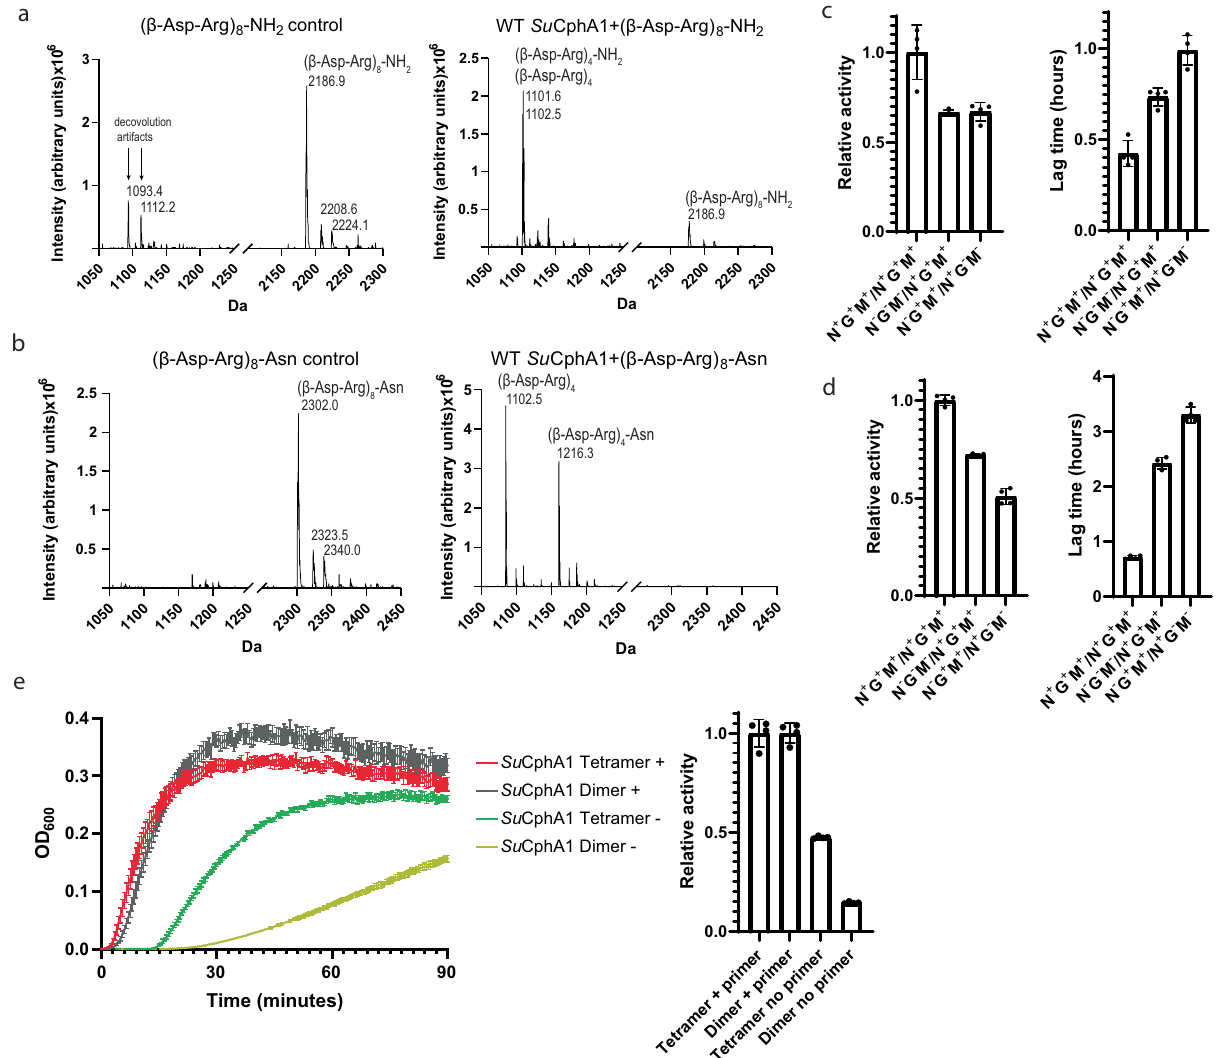
Fig. 4 Catalytic activity of the N domain and cyanophycin synthesis by dimeric CphA1. a Mass spectra of ( β -Asp-Arg) 8 -NH 2 , an 8mer cyanophycin segment in which the terminal carboxylate is replaced by an amide, before (left) and after (right) incubation with WT Su CphA1. After incubation with enzyme, the peak corresponding to ( β -Asp-Arg) 8 (expected at 2187.0 Da) is reduced, and two peaks with sizes matching to ( β -Asp-Arg) 4 (expected at 1102.5 Da) and ( β -Asp-Arg) 4 -NH 2 (expected at 1101.5 Da) appear. Peaks corresponding to Na + and K + adducts are also labeled. Peaks at 1093.4 and 1112.2 Da are deconvolution artifacts (Supplementary Fig. 5). b Mass spectra of ( β -Asp-Arg) 8 -Asn before (left) and after (right) incubation with WT Su CphA1. After incubation with enzyme, the peak corresponding to ( β -Asp-Arg) 8 -Asn (expected at 2301.1 Da) disappears and two peaks with sizes matching to ( β -Asp-Arg) 4 (expected at 1102.5 Da) and ( β -Asp-Arg) 4 -Asn (expected at 1216.6Da) appear. c , d Activity rate and lag time of Su CphA1 dimer complementation assays with c and without d primer. In presence of exogenous primer, the two mutant combinations G − M − N − /G + M + N + and G − M + N + /G + M − N − display a similar activity rate, although the G − M + N + /G + M − N − combination displays a somewhat longer lag time. In the absence of primer, the G − M − N − /G + M + N + combination displays a somewhat higher activity rate and lower lag time. n = 4 independent experiments. Data are presented as individual measurements and mean value, error bars represent SD values. e Activity assays and activity rate comparison of WT Su CphA1 (tetramer) and the W672A mutant (dimer) with ( + ) and without ( − ) primer. The two enzymes display similar primer-dependent activity, but the dimer has lower primer- independent activity. n = 4 independent experiments. Data are presented as individual measurements and mean value, error bars represent SD values.